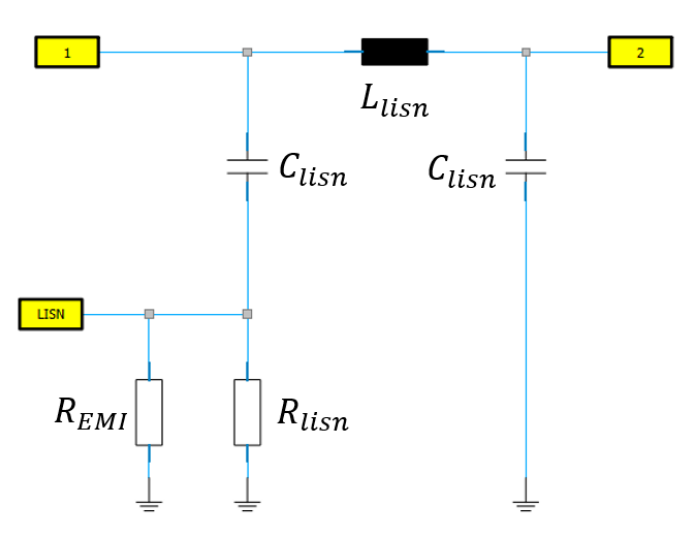
Figure 20. Equivalent circuit model of the LISN [19]. The parameter values are listed in Table